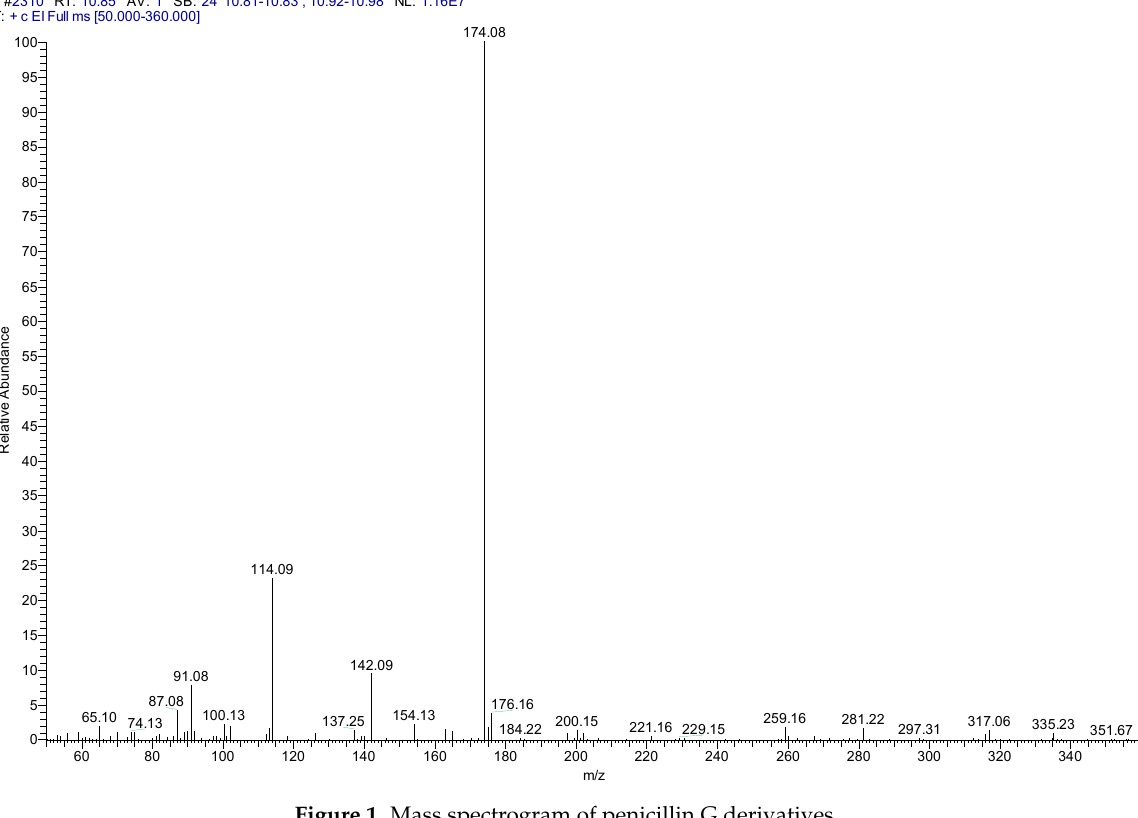
Figure 1. Mass spectrogram of penicillin G derivatives. Table 1. Retention time and relevant MS parameters of penicillin G trimethylsilyl methyl